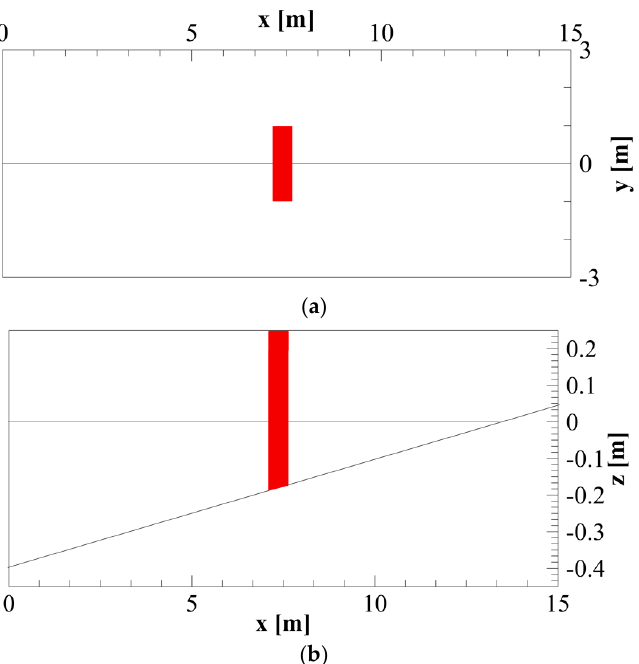
Figure 13. Wave–structure interaction. Coastal area with a vertical emerged barrier (in red). ( a ) Plan view. ( b ) Vertical section.